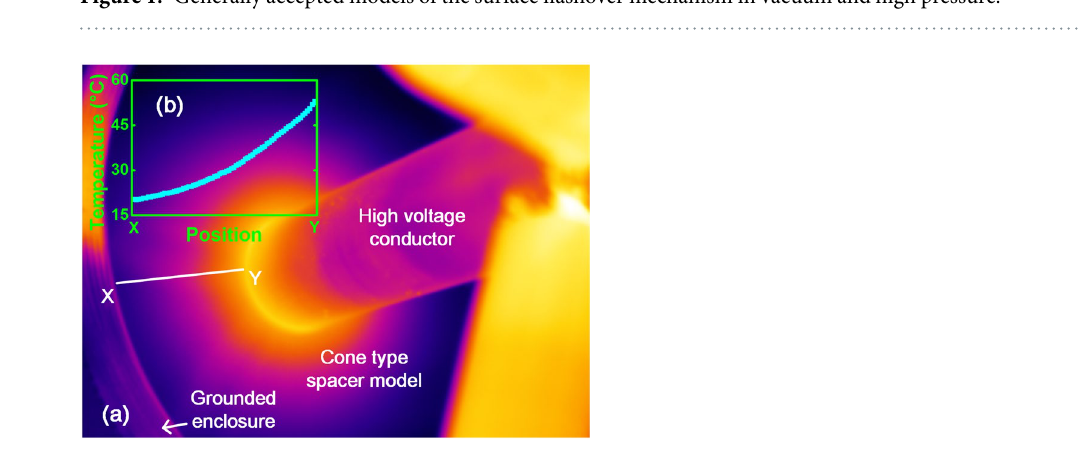
Figure 2. ( a ) Infrared imaging of cone type spacer model with the temperature of the high voltage conductor reaching 60 °C after 20 min in ambient environment and ( b ) temperature gradient from the grounded enclosure (X) to the high voltage conductor